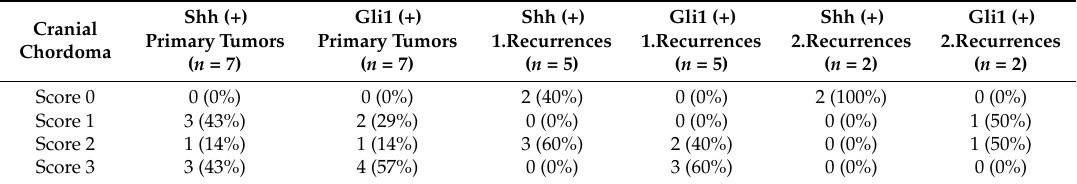
Table 2. Immunohistochemistry: distribution and responsiveness of the cranial chordomas in eight patients and 14 samples divided into seven primary tumors, five first relapses and two second recurrences.